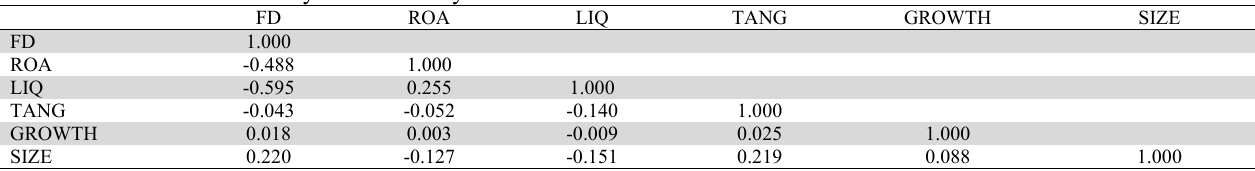
Results of autocorrelation analysis in the study model FD